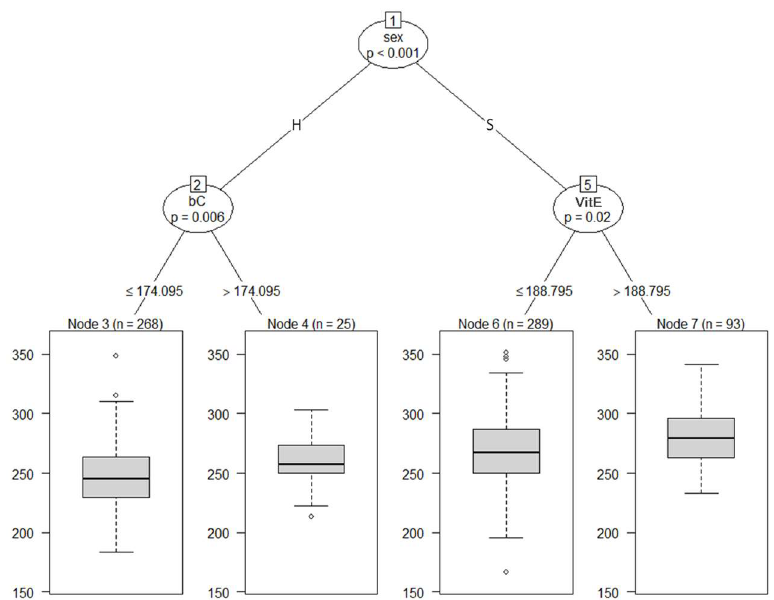
Figure 3. The graphical model of regression tree for body weight. A total of 675 animals with the adjusted phenotypic values for the fattening starting age (8 months) and the slaughter age (29 months) were used in the analysis. Body weight was used as a dependent variable, and sex (S = steer, H = heifer) and 8 blood metabolites were used as independent variables. A total of 675 animals with the adjusted phenotypic values for the fattening starting age (8 months) were used in the analysis. Abbreviations of traits are shown in Table 1.